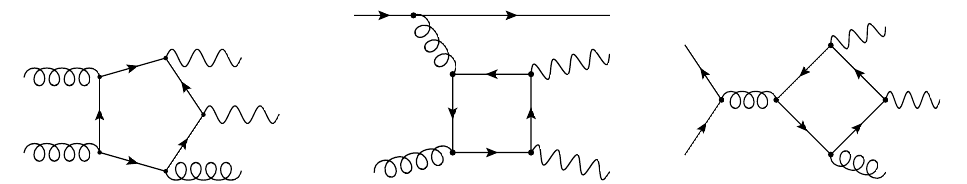
Figure 2. Examples of diagrams contributing to the real radiation